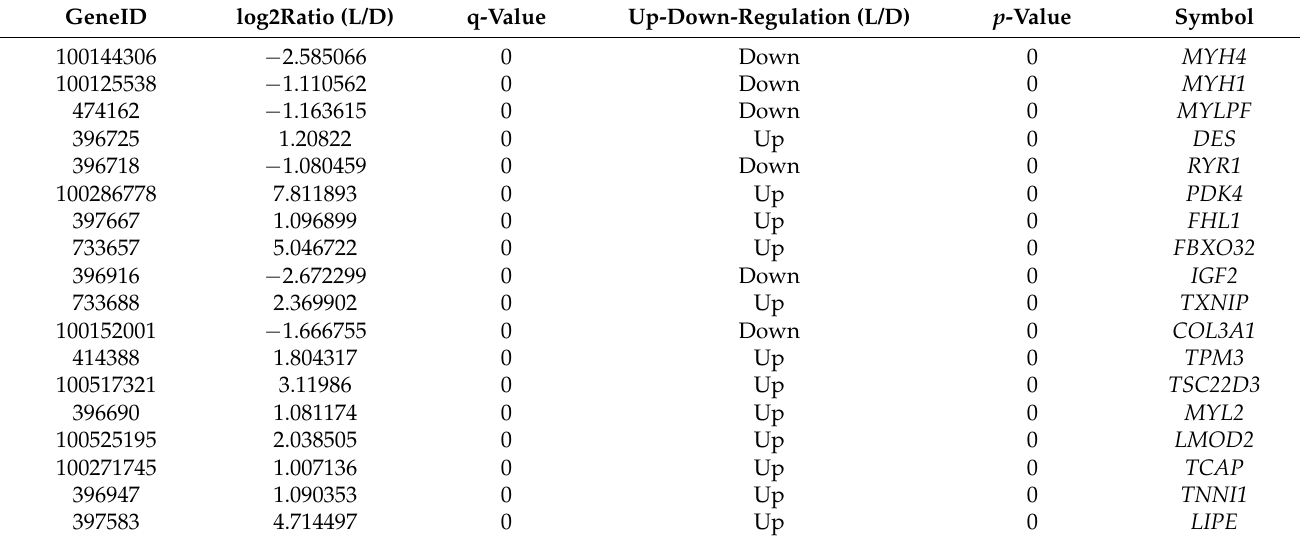
Table 4. Candidate genes related to growth and development in